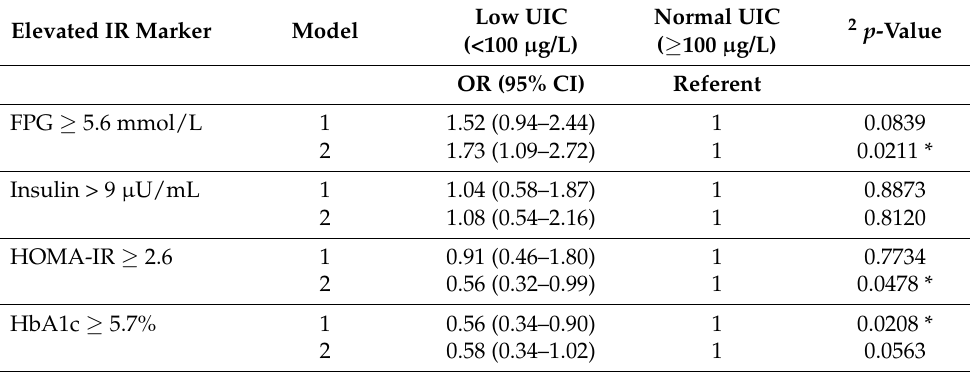
Table 6. Prevalence of elevated markers insulin resistance in relation to urinary iodine concentration in US female adults, NHANES 2011–2012 1